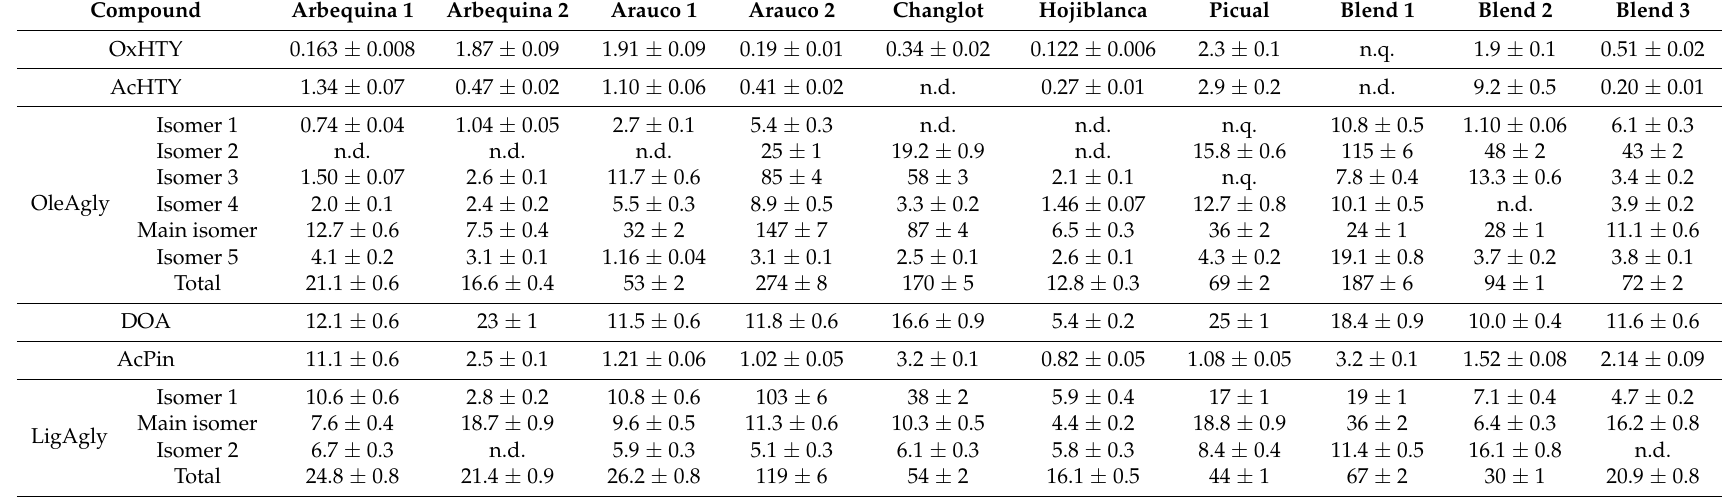
Table 4. Content of phenolic compounds whose pure standard is not commercially available (expressed in µ g · g − 1 ) achieved by